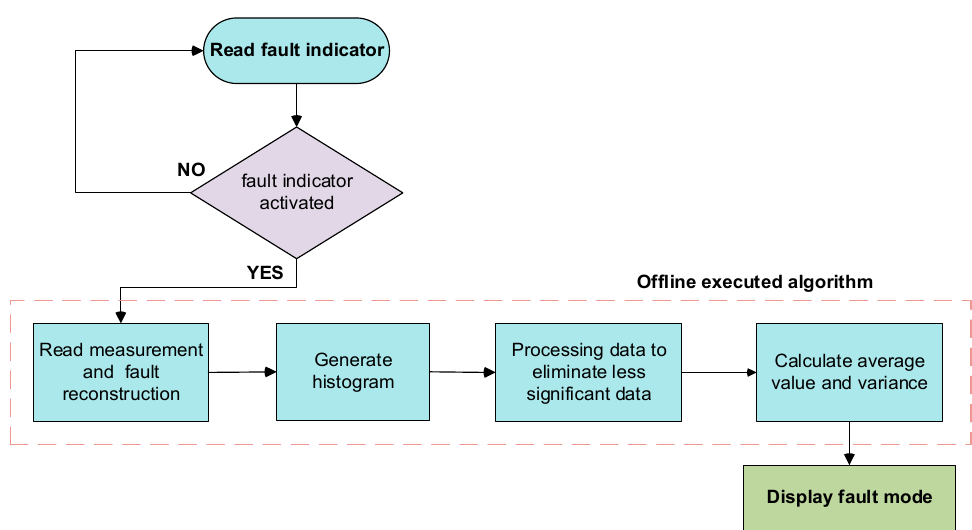
Figure 17. Flowchart for the procedure to discern gain and offset faults.